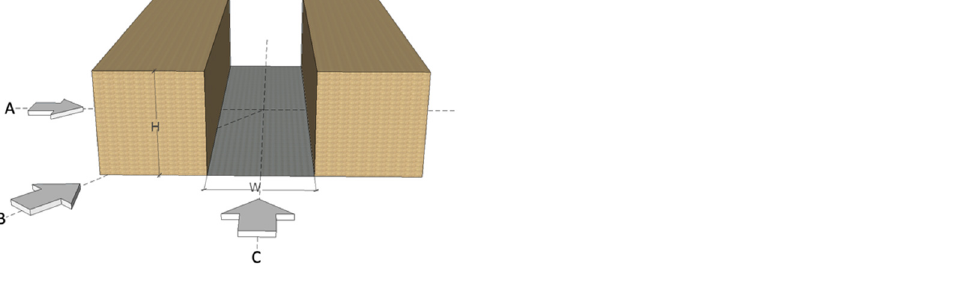
Figure 2. An example of an isolated street canyon and different inflow directions; perpendicular (A), Oblique (B) and Parallel